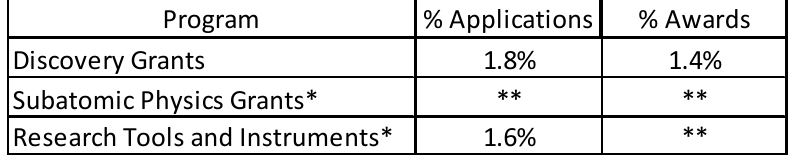
Persons with a Disability, 2020 Competition